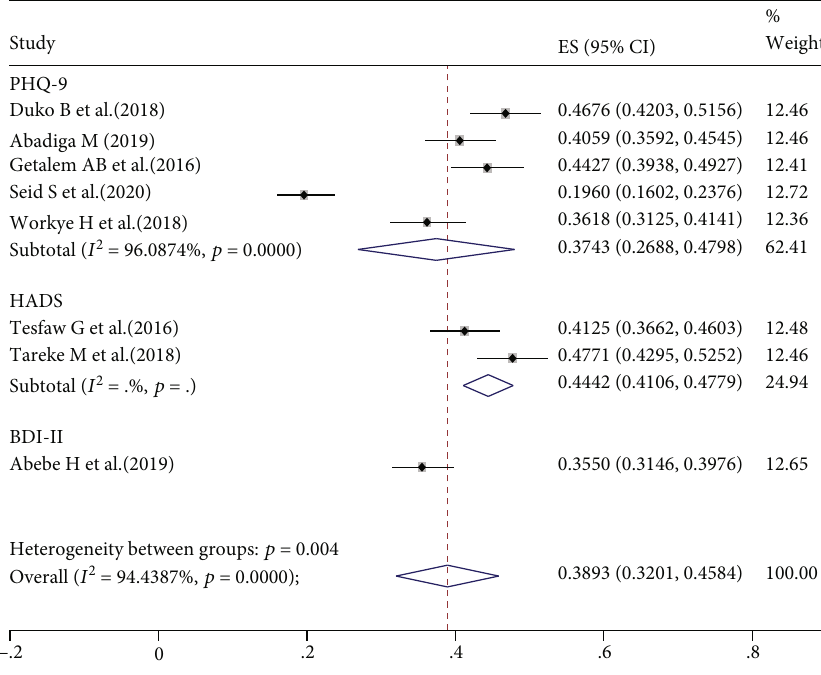
Figure 3: The pooled estimated prevalence of depression among HIV/AIDS patients in Ethiopia based on tools,